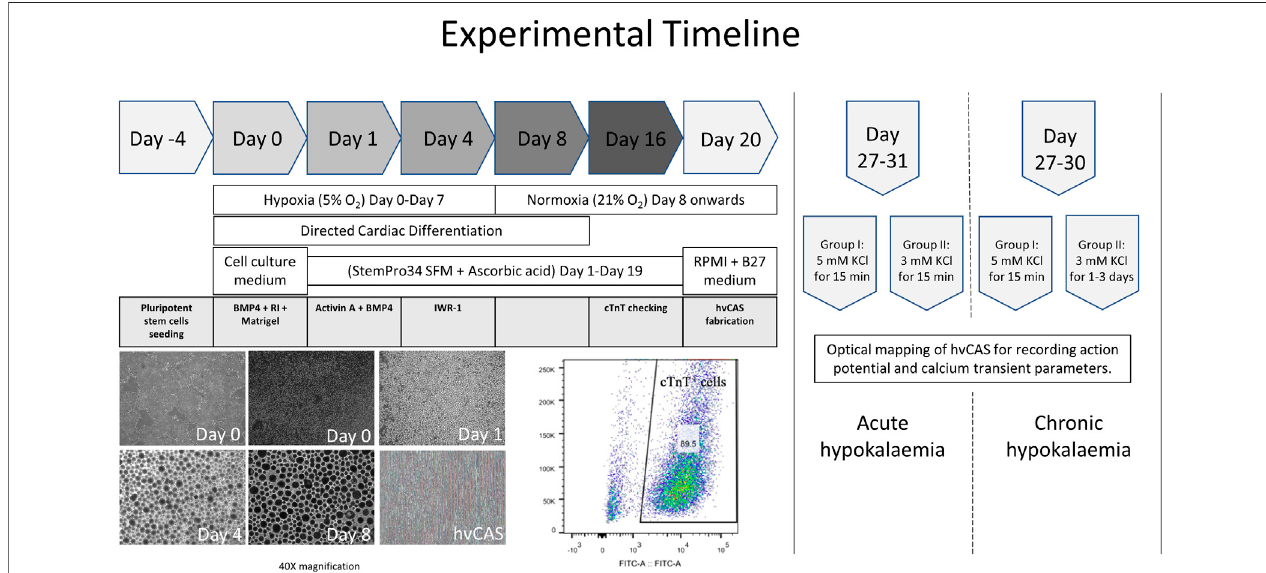
FIGURE 1 | Experimental timeline from human pluripotent stem cell seeding, their directed cardiac differentiation, and hvCAS fabrication to an action potential and calcium transient data acquisition. The photos are of human embryonic stem cells (hES2), which show the cells ’ morphology at different time points of directed cardiac differentiation. The photos are taken at 40X magni fi cation. Cardiomyocyte yield from hES2 shows 89.5% cTnT + cells, which were then used for downstream experiments.